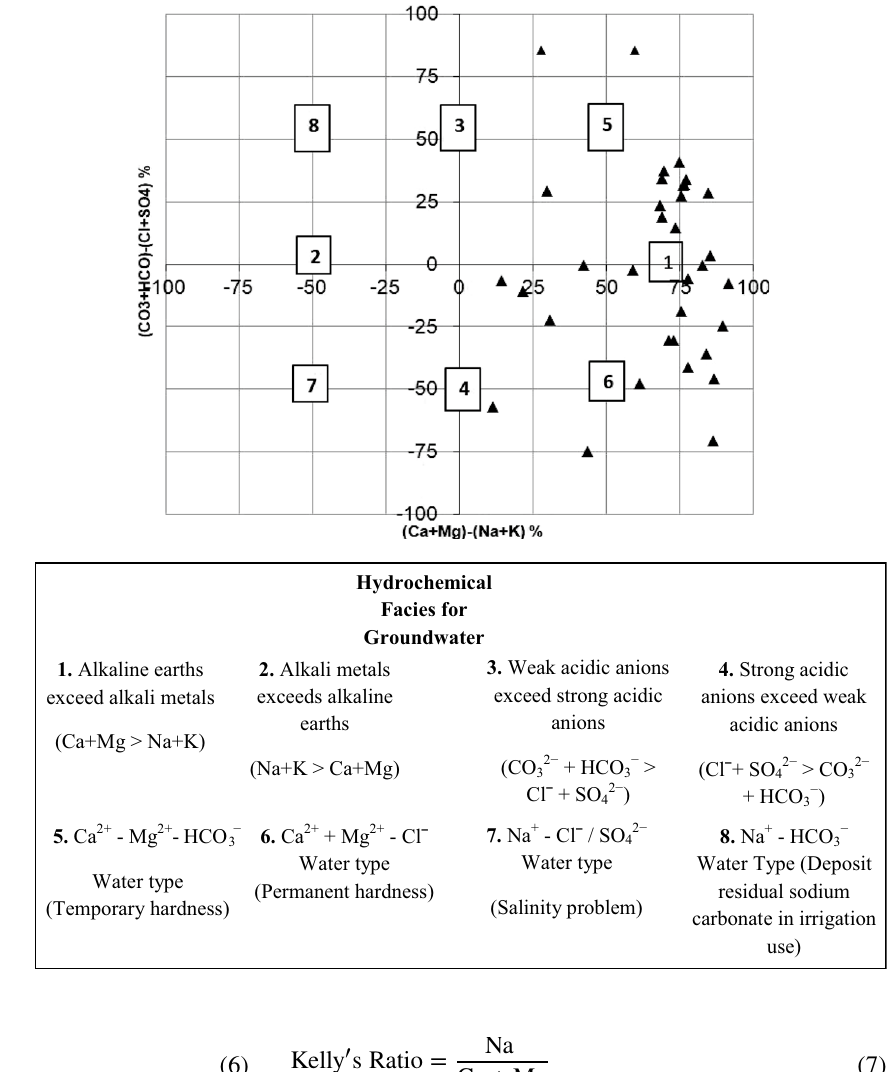
Fig. 32 Chadha’s diagram (pre-